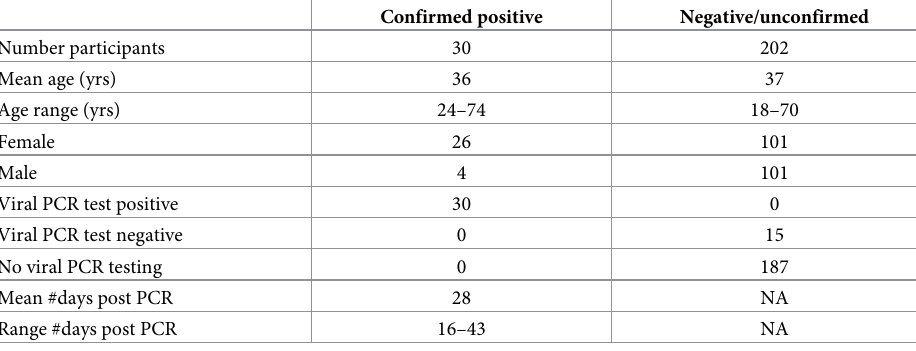
Table 1. Characteristics of study